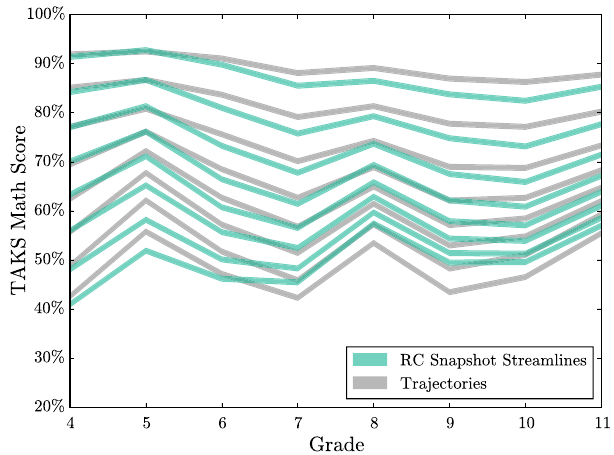
FIG. 12. RC snapshot streamlines for 2008 – 2009 and trajecto- ries for the 2012 cohort. The students are sorted into score bins by their 2008 reading exams and the changes in scores are calculated between their 2008 – 2009 mathematics exams.